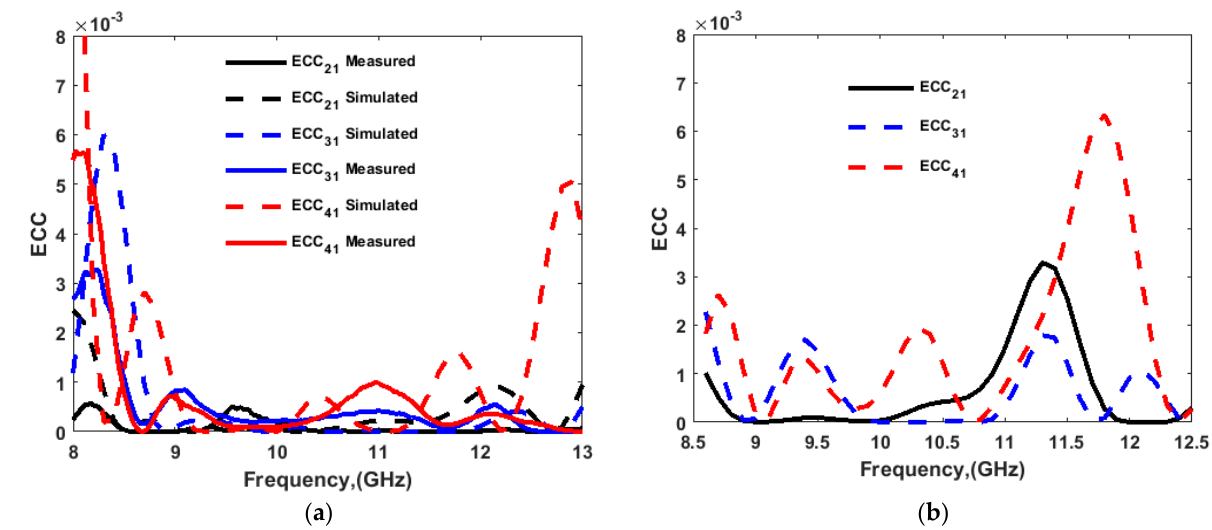
Figure 18. ECC ( a ) measured and simulated from S-parameters; ( b ) from far-field.